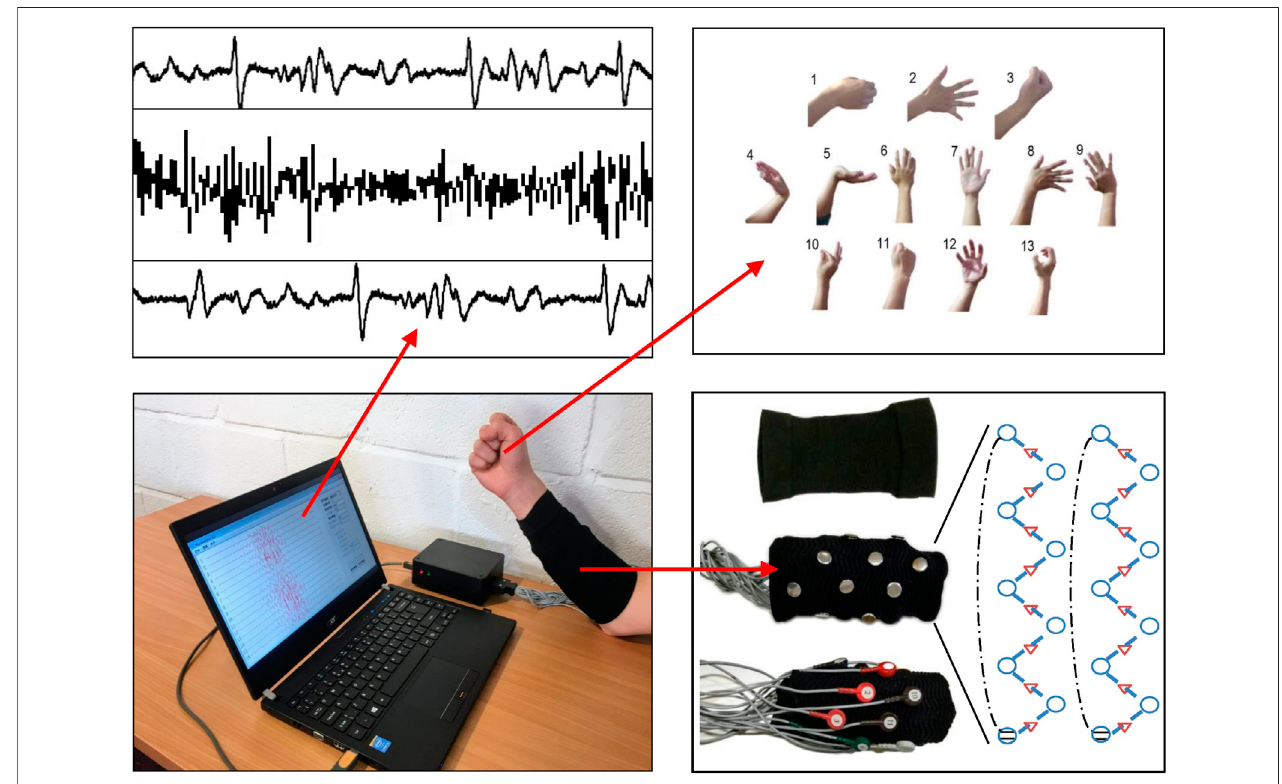
FIGURE 6 | It is a conceptual diagram of the experimental setup and data collection scenario. It describes the process of collecting EMG signals of 13 gestures under 16 channels.